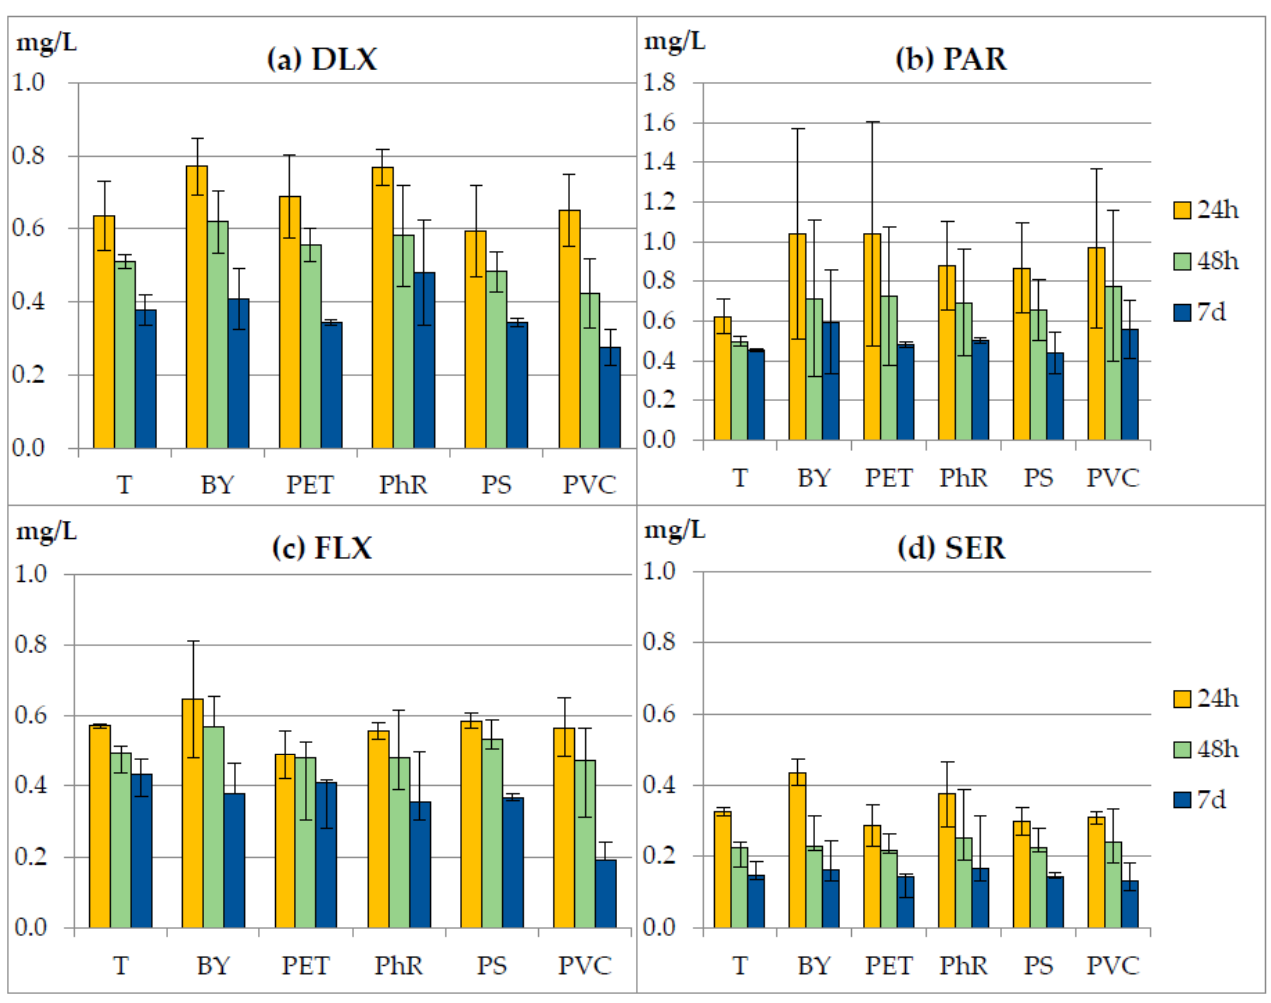
Figure 3. Acute toxicity data in the Spirotox test (EC 50 ) of the tested pharmaceuticals with and without microparticles, ( a ) duloxetine; ( b ) paroxetine; ( c ) fluoxetine; and ( d ) sertraline. T—Tyrode’s medium, BY—baker’s yeast, PhR—phenolic resin, PVC—polyvinyl chloride, PET—ethyl polyterephthalate, PS — polystyrene.